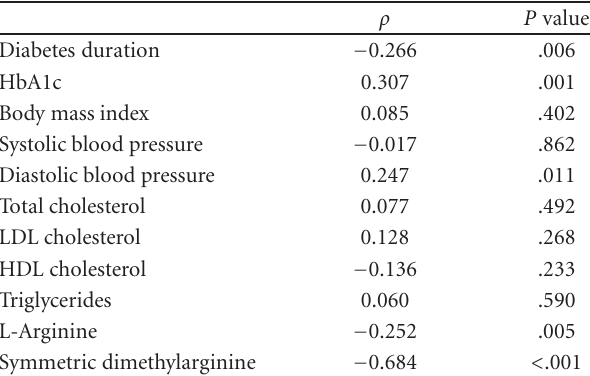
Table 4: Spearman correlations of GFR with other